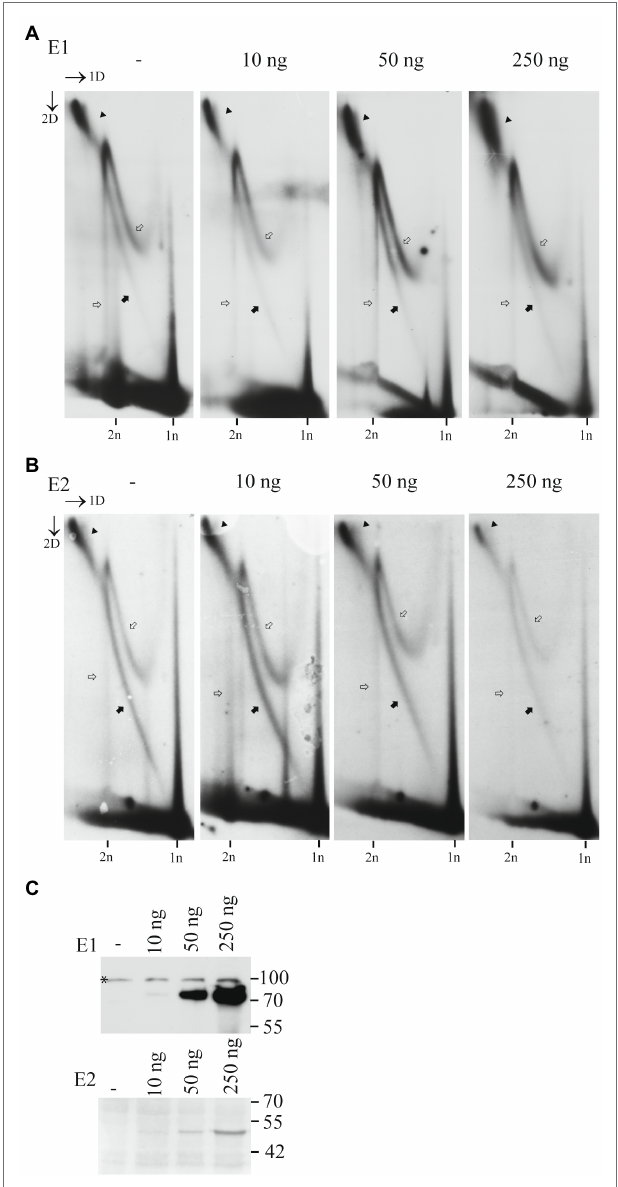
FIGURE 4 | Mechanism of replication initiated from the HPV18 ori does not depend on the E1 and E2 protein levels. (A) Neutral-neutral 2D analysis of the replication intermediates arising from the HPV18 E8-genome replication in the presence of growing amounts of the E1 expression vector. (B) Neutral-neutral 2D analysis of the replication intermediates arising from the HPV18 E8- genome replication in the presence of growing amounts of the E2 expression vector. Episomal DNA was extracted 72 h after the transfection, linearized with a restriction enzyme BglII cutting near the ori, run on an agarose gel at two dimensions and analyzed by SB. Black arrows refer to the theta replication intermediates, black arrowheads refer to the almost fully replicated genomes, white arrows refer to the non-theta replication intermediates. (C) Western blot analysis showing the expression levels of the HPV18 E1 and E2 proteins, when co-transfected together with the HPV18